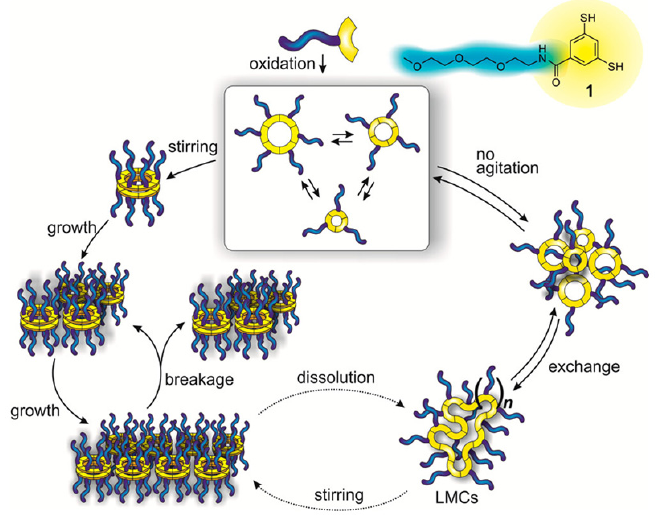
30 of 45 Figure 30. ( a ) Ring opening polymerization of 1,2-ditholane pendant group in the hydrophobic micelle cores upon exposure to a small molecule thiol. ( b ) Ring opening polymerization energy profiles (relative) for TMCLA (green) and TMCDT (blue) monomers. Reprinted with permission from [31]. Copyright (2014) American Chemical Society.